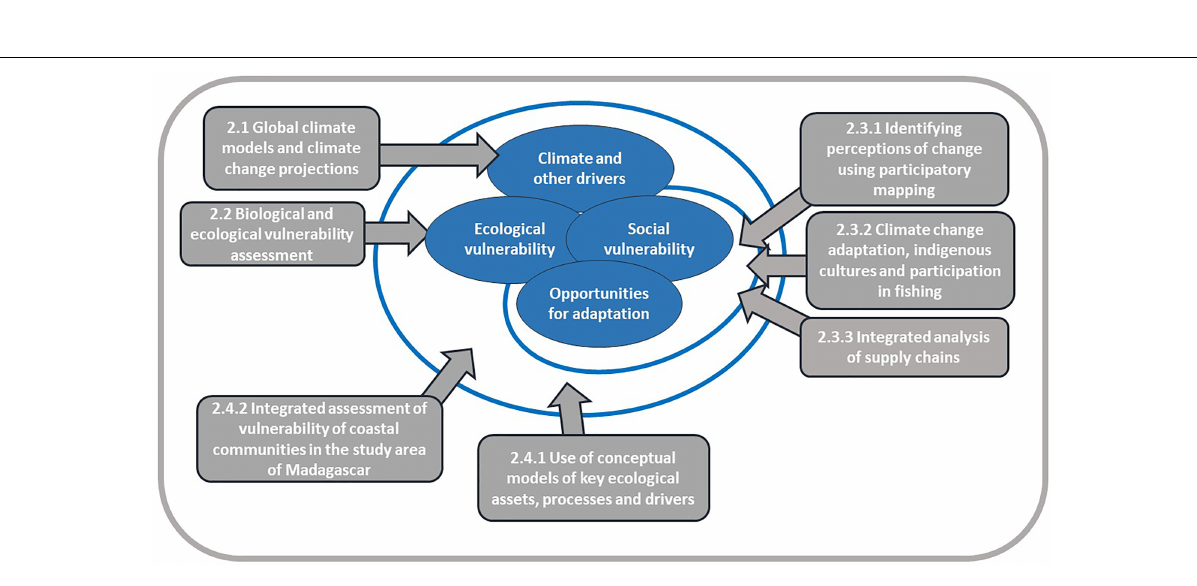
FIGURE 2 | The methodology applied in the different activities undertaken in the GLORIA project and the socio-ecological scope of each activity and, where relevant, its sub-components. Elements of socio-ecological vulnerability and adaptation are shown in blue, and activities and sub-activities addressing individual or aggregated elements of vulnerability/adaptation are shown in gray boxes. Numbers refer to the section under Materials and Methods providing details of the activities. A separate activity on communicating ocean science and climate change to communities and stakeholders was also undertaken but did not form a part of the vulnerability assessment and is not shown